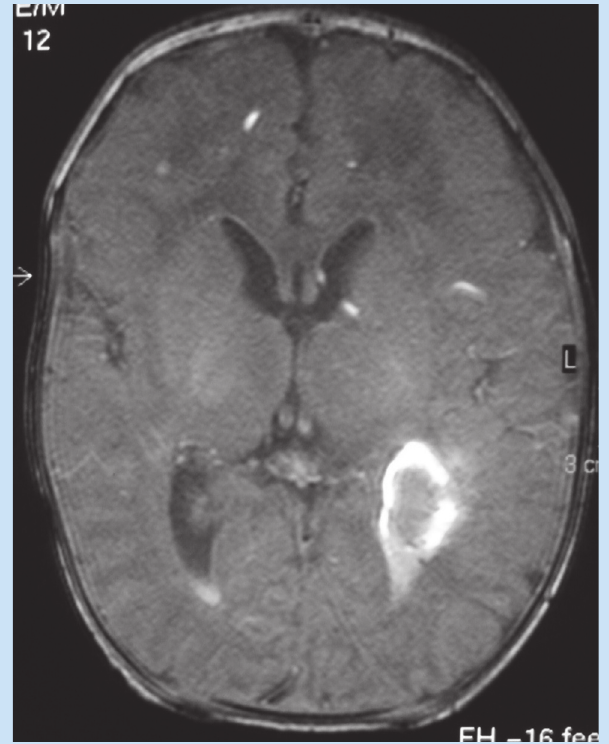
Fig 1. There is a haematoma adjacent to the left trigone that is hyperintense on T1. Blood is also present within the lateral ventricle.